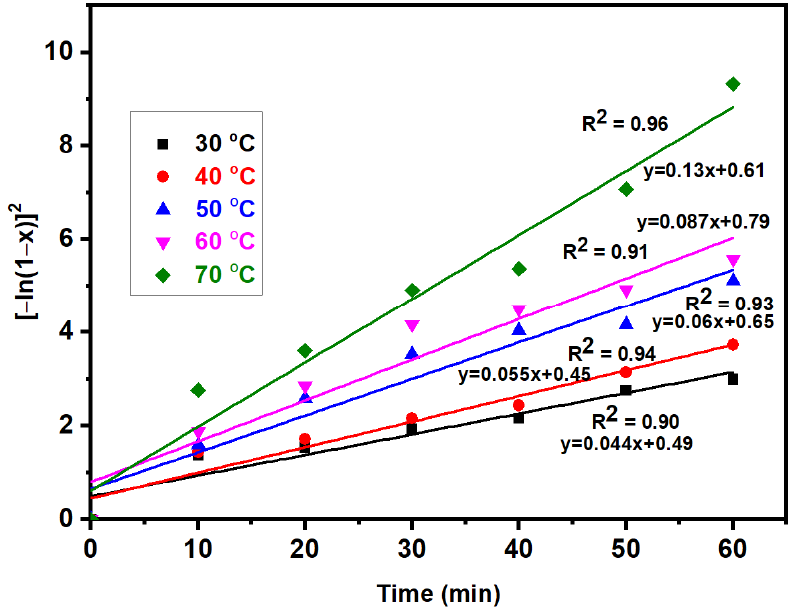
Figure 9. Empirical model for kinetics of leaching of gold (temp. 30 to 70 °C).